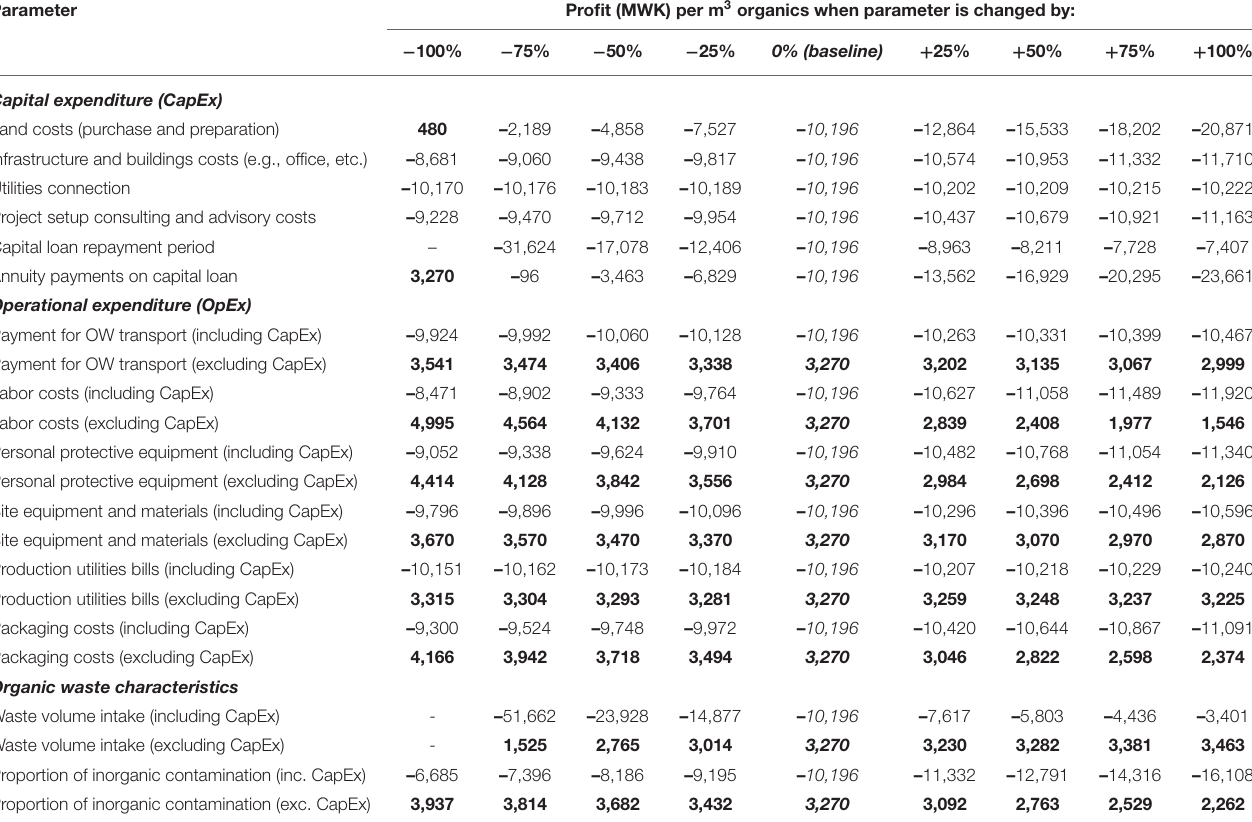
TABLE 2 | Effect of changing model parameters on profitability (bold indicates changes that result in